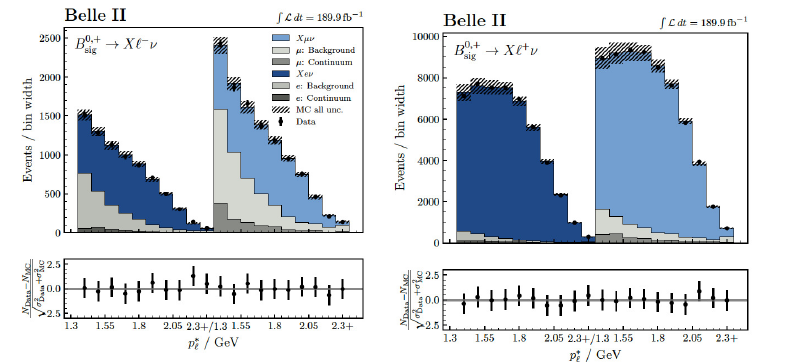
Figure 3. Distributions of Lepton momentum in the B sig frame ( p ∗ sign (right). The electron and muon templates are fitted simultaneously in 10 p ∗ 100 MeV each covering a p ∗ range from 1.3 GeV to 2.3 `